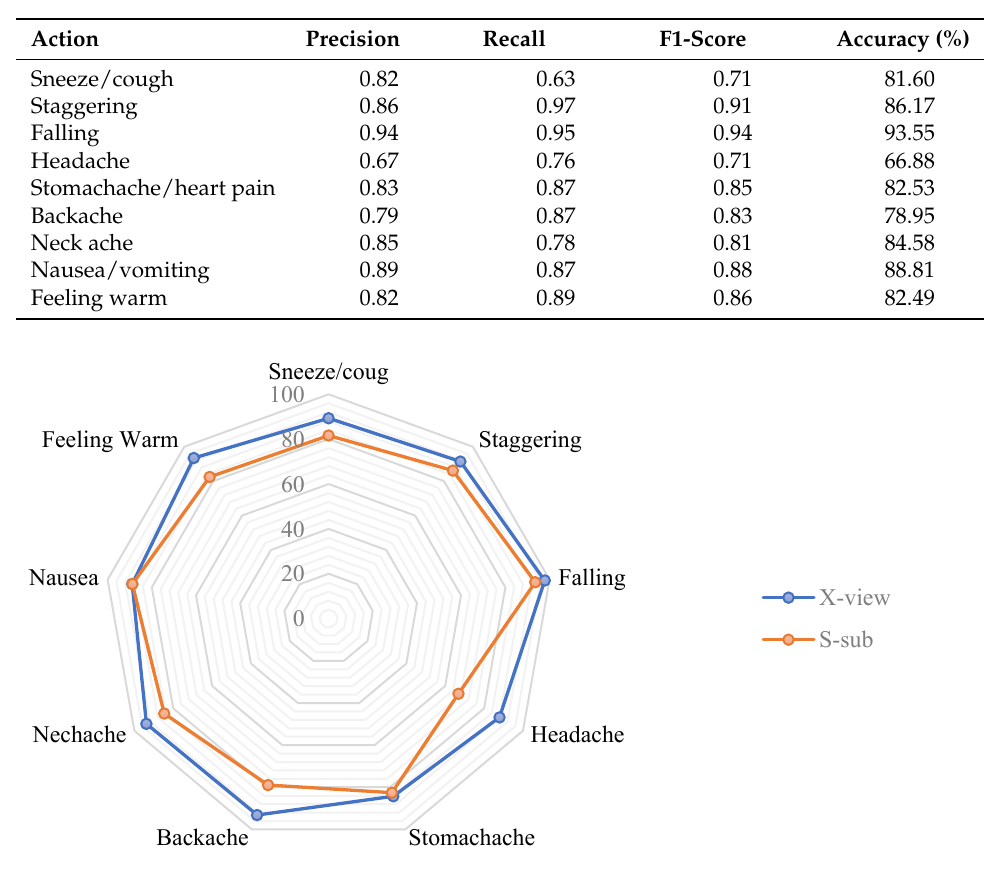
Figure 10. Accuracy of STGCN for medical condition- related actions.